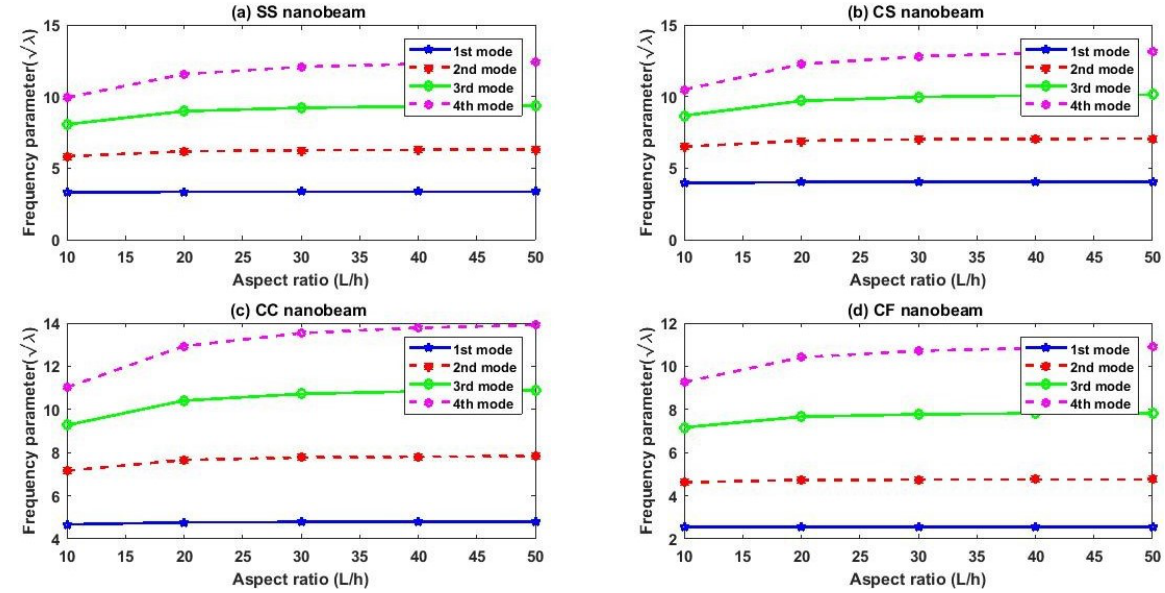
Figure 4: Variation of frequency parameter with length-to-height ratio Table 18: Frequency parameter length-to-height ratio L / h